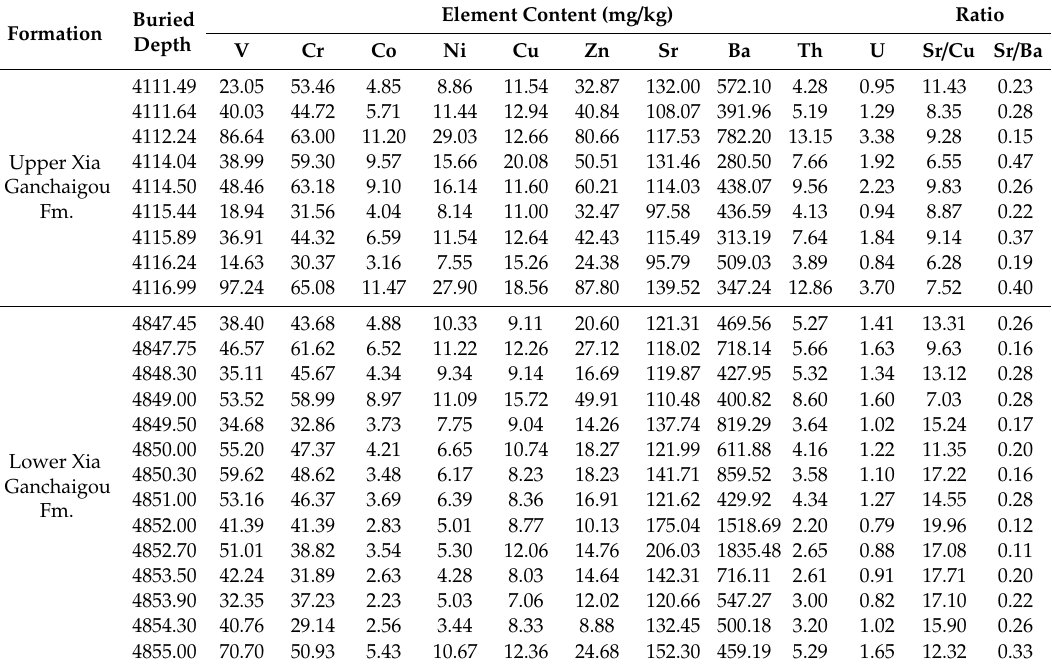
Table 3. Partial trace element content of the Xiaganchaigou Formation in the Lenghuqi Area. Buried Formation Depth